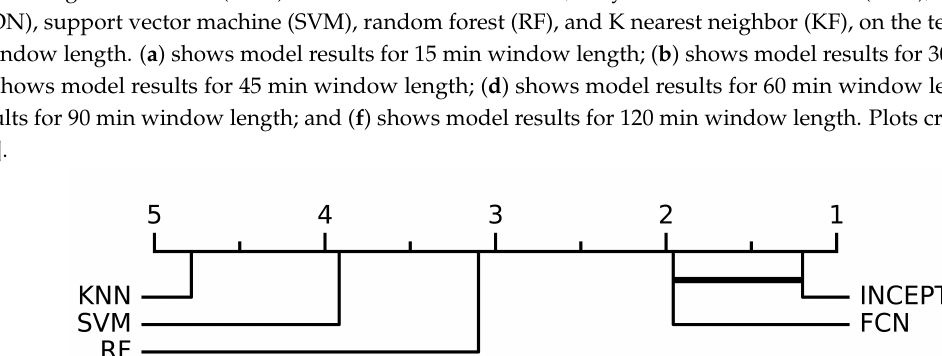
Figure 4. The critical difference diagram of the Nemenyi test with significance level α = 0.05 for the different evaluated models. The test set were divided into 10 equally sized parts when performing the analysis, which combined with the 6 window lengths analyzed in this study (15 min, 30 min, 45 min, 60 min, 90 min, and 120 min) and resulted in a total of 60 evaluations for every model. The critical difference diagram shows that the FCN and INCEPTION models’ performance were not statistically significant according to the Nemenyi test. FCN and INCEPTION were, however, statistically significantly better compared with the other evaluated models, SVM, RF, and KNN, according to the test. The performances of SVM, RF, and KNN were also statistically significant different compared with each